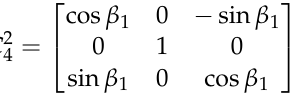
β 1 is the LOS attitude of each reflector. In order to eliminate the doubled optical coupling effect, we need to establish a reflector coordinate system with a double LOS. The vector r 4 i in six reflector coordinate systems is projected into the reflector coordinate system with double LOS to obtain the vector r 1 . According to Euler’s theorem and Snell’s law of 4 i reflection, the transformation matrix between the two coordinate systems is